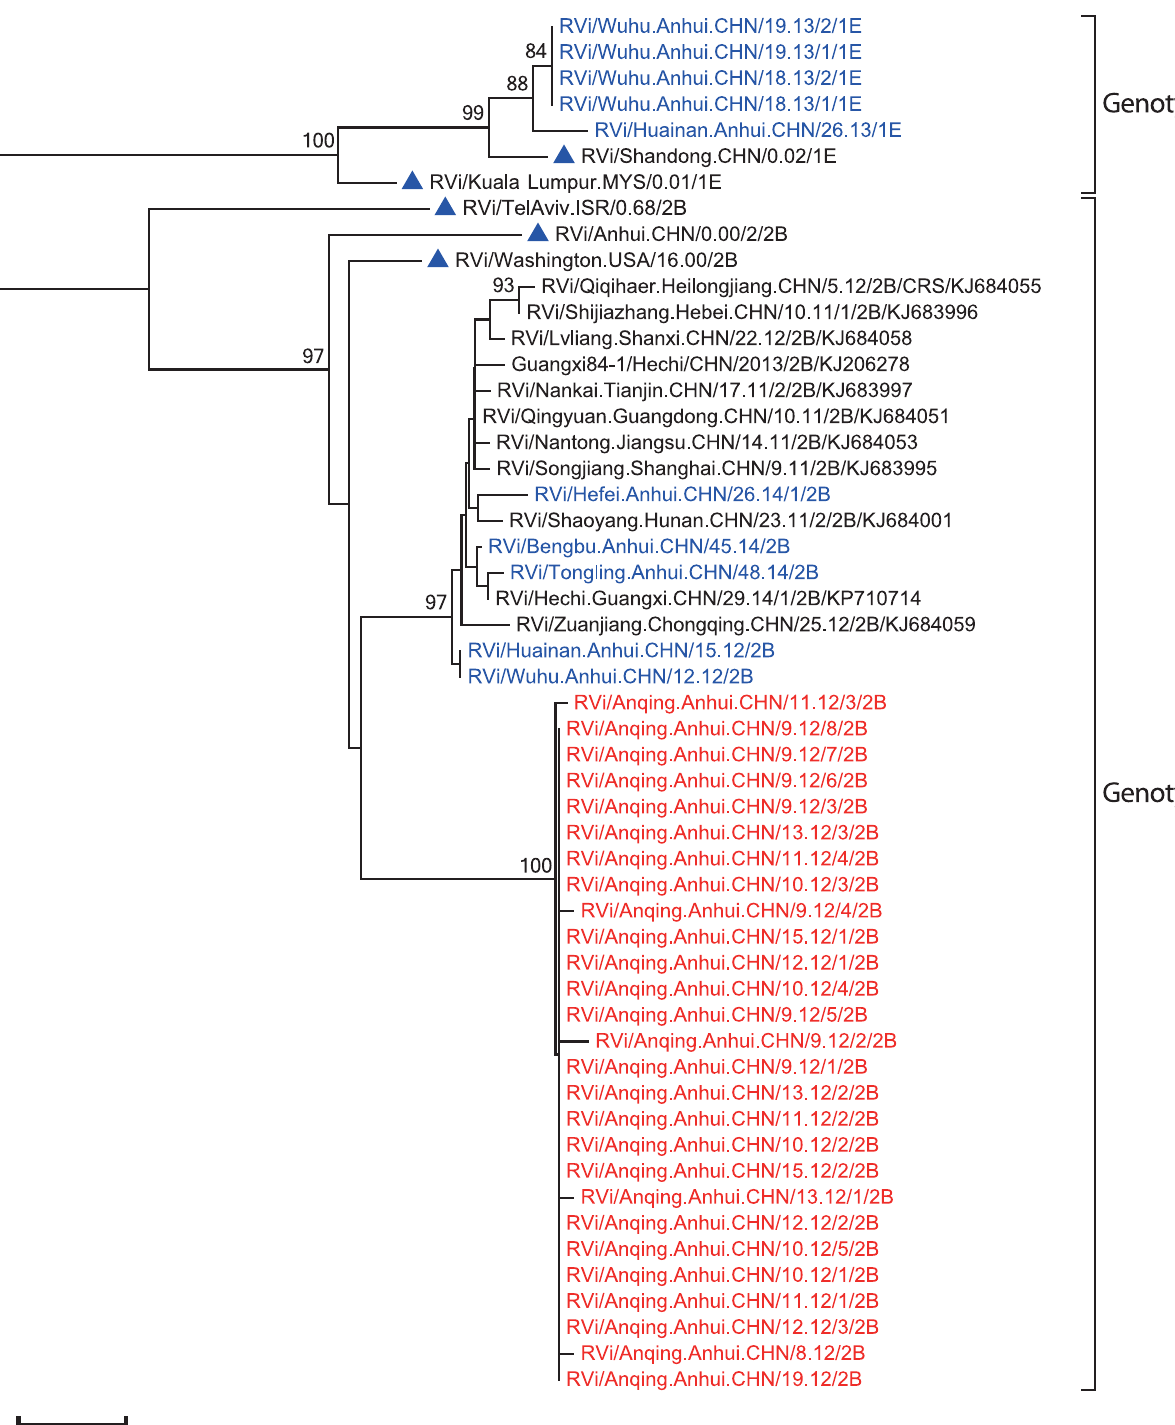
Fig 6. Phylogenetic analysis of the sequences of 27 Anqing RVs (shown in red), 10 RVs collected in 5 cities of Anhui province between 2012 and 2014 (shown in blue), and 11 2B RVs from other provinces of China during 2011 – 2014 based on the WHO standard 739-nt window. Genotype 1E and 2B WHO reference strains are indicated by blue